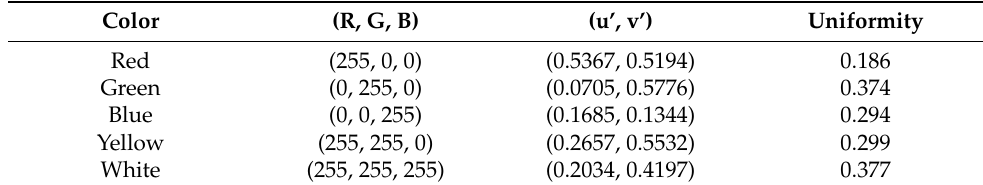
Table 3. Colorimetric characteristics of the five achromatic colors.